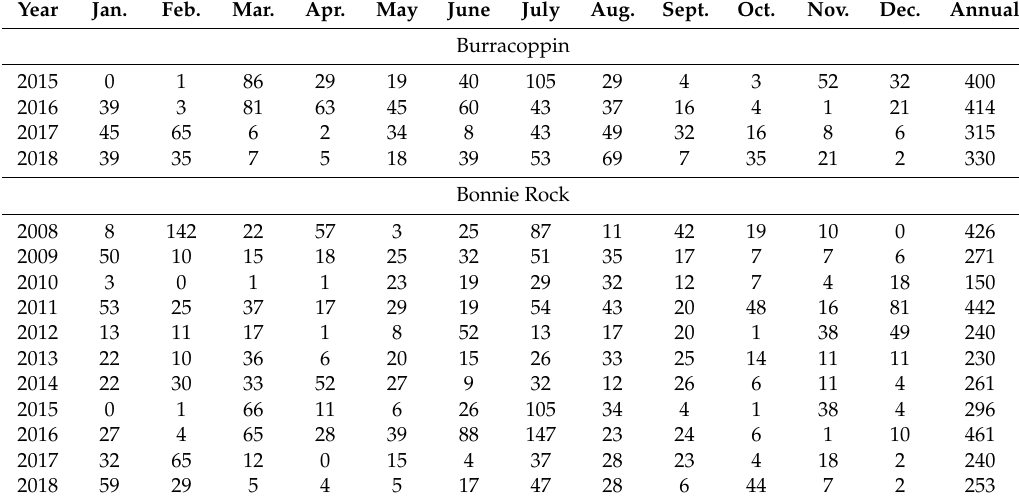
Table 2. Monthly and annual rainfall (mm) at the ST and MT experimental sites (Burracoppin) over the three years (2015–2018) and the LT trial site (Bonnie Rock) over the 10 years